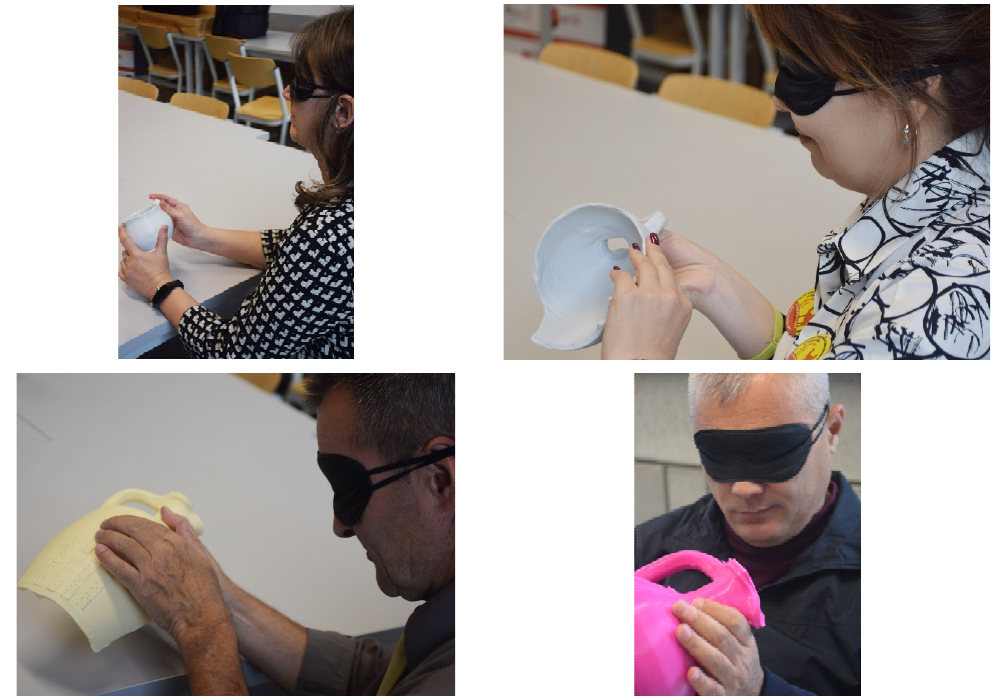
Figure 12. Studies involving people with simulated visual impairment. Stage 2—examination of a blind person.